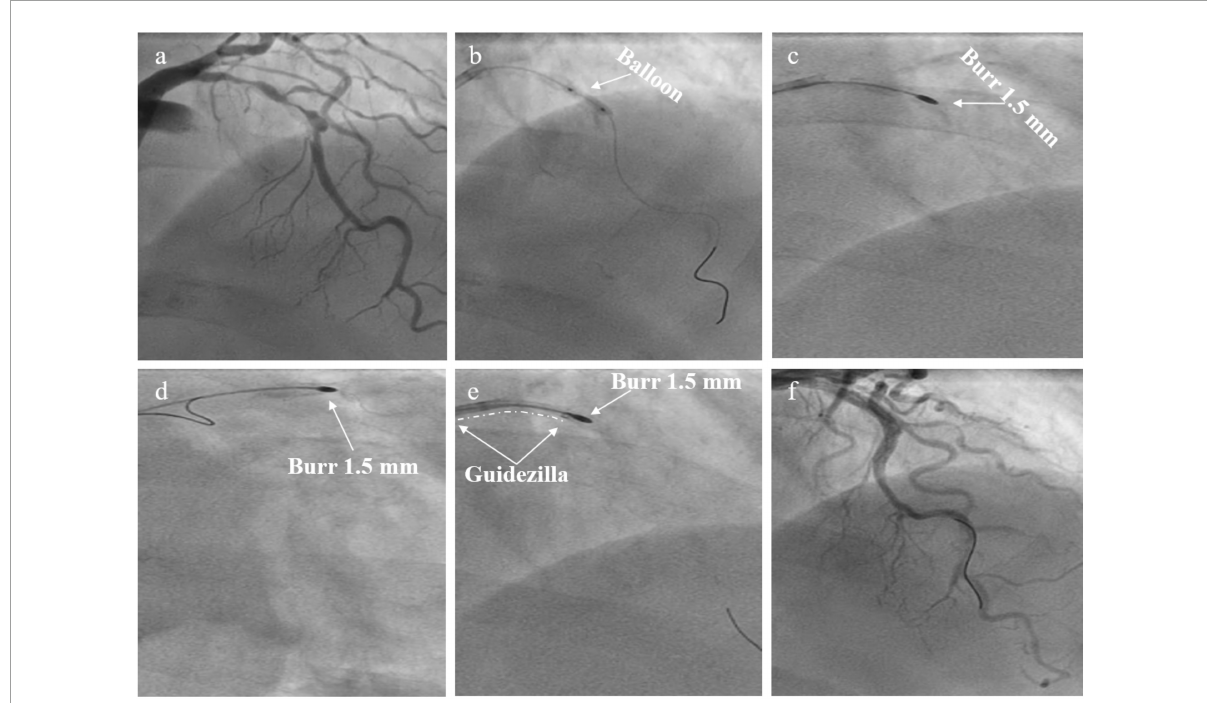
FIGURE3 Typical examples of TRI using the GGEC I in different situation ( Case 1–6 ). Case 1 : an example of percutaneous coronary intervention (PCI) using the Guidezilla TM guide extension catheter I (GGEC I) in left ascending artery chronic total occlusion (LAD CTO) using the antegrade